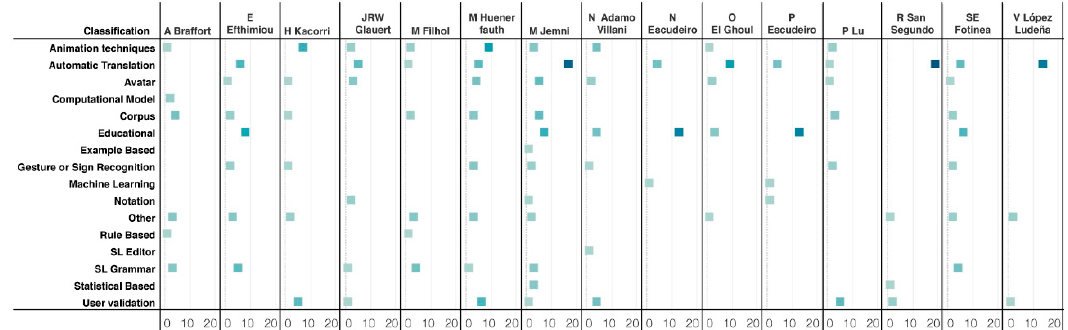
Figure 6. Top authors and classification level chart. Table 2. Classification–Subclassification top 3 co-occurrence frequency.